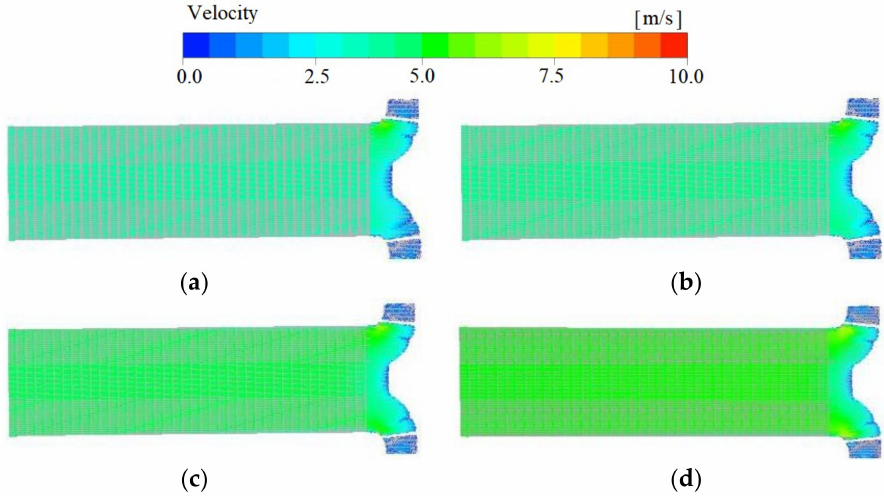
Figure 7. Relative velocity vectors in the axial section of the pump at different flow rates: ( a ) 800 m 3 /h; ( b ) 1000 m 3 /h; ( c ) 1100 m 3 /h; ( d ) 1300 m 3